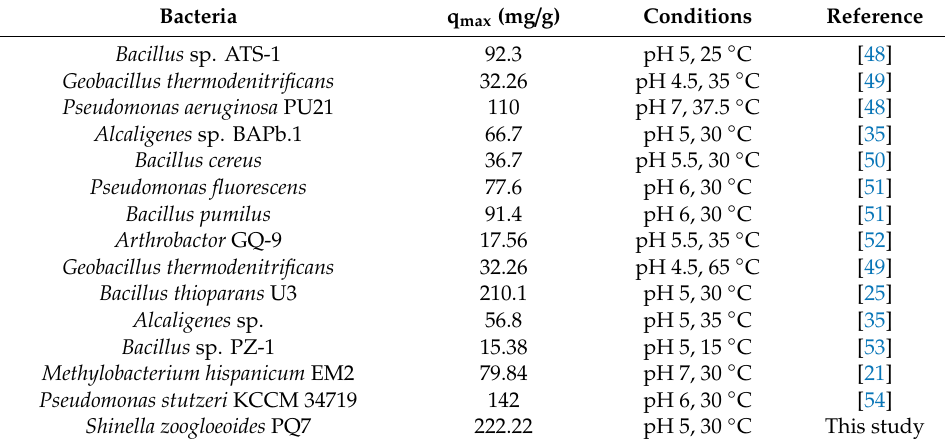
Table 2. Comparative analysis of biosorbents for Pb(II)